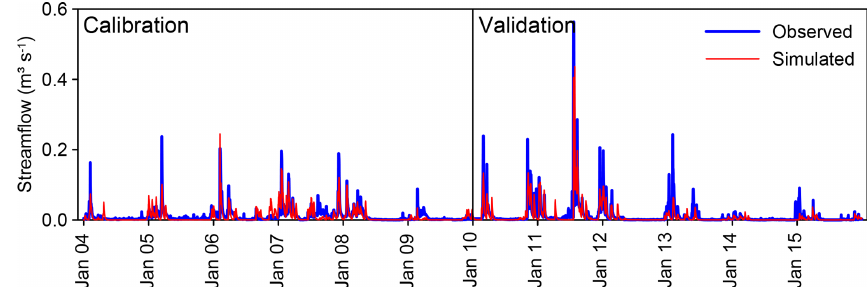
Figure 3. Observed and simulated hydrographs at a daily time scale during the calibration and validation period.